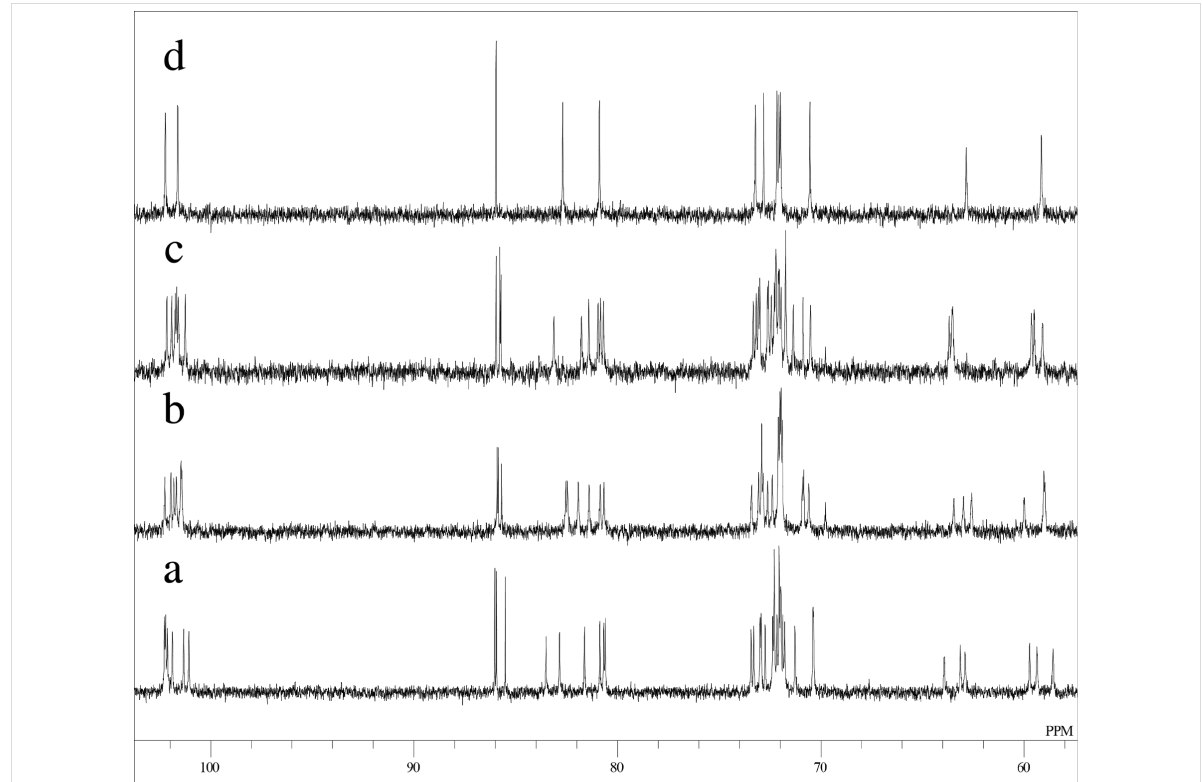
Figure 4: A part of 13 C NMR spectra of tri-6- O -trityl- α -CD in DMSO- d 6 at 50 °C. a) ABE-isomer, b) ABD-isomer, c) ABC-isomer, and d) ACE-isomer.